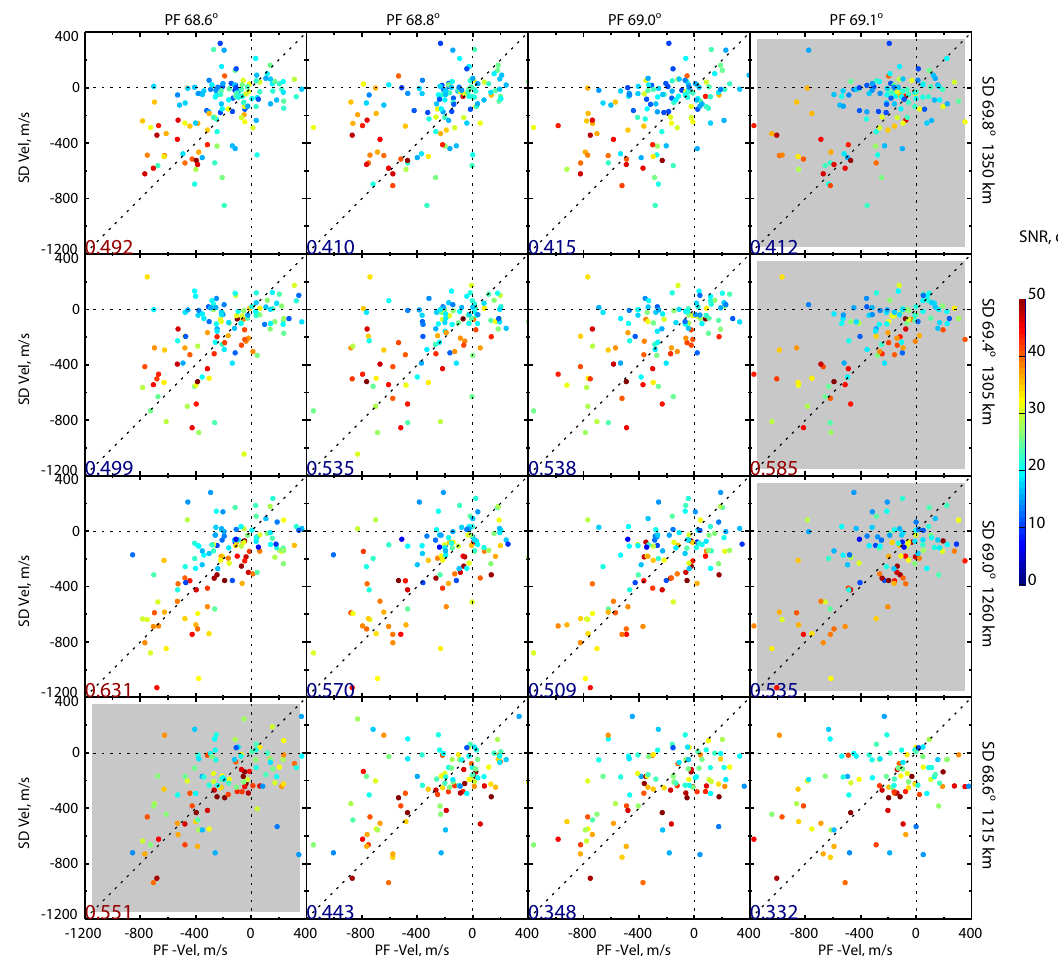
Figure 3. Scatter plots of the SuperDARN KOD Doppler velocity (SD Vel) in beam 3 versus the reversed PFISR ion drift velocity in beam 64079 (PF-Vel). The columns (rows) refer to 4 selected MLATs of the PFISR (KOD) observations as given at the top (right). The points are color-coded in SNR measured by KOD. The digits in the bottom-left corner of each panel show the linear Pearson correlation coefficient between the two velocity data sets. The red digits indicate the maximum correlation for a given KOD range gate (within the PF range gates considered here). The panel highlighted with a grey background refers to the nominally matched MLATs (also within the considered PF